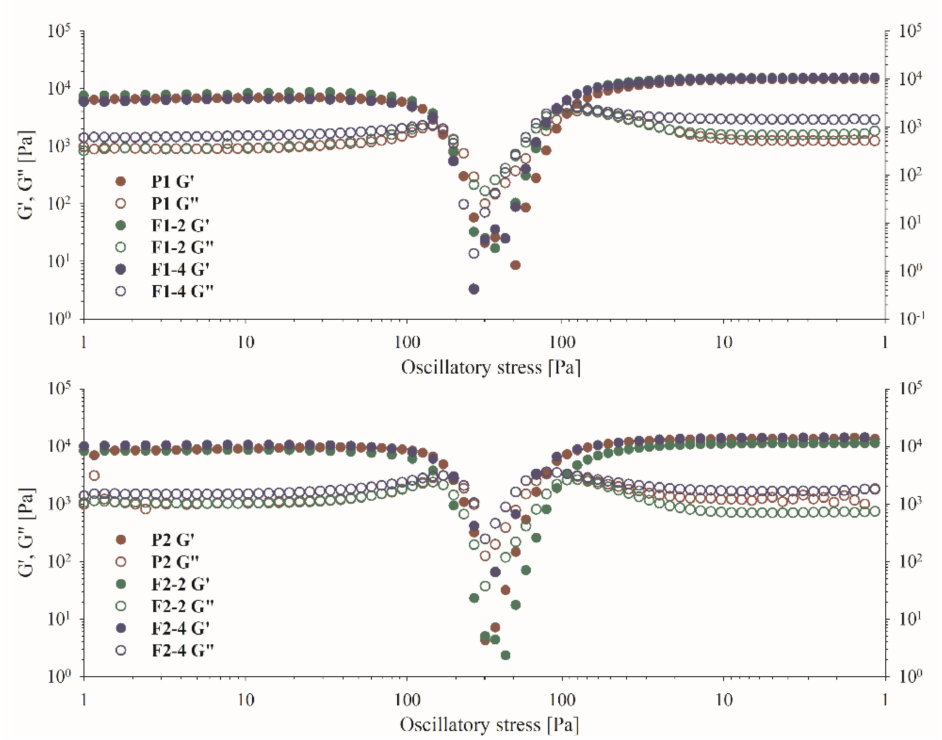
Figure 5. The oscillatory stress sweeping of the gel